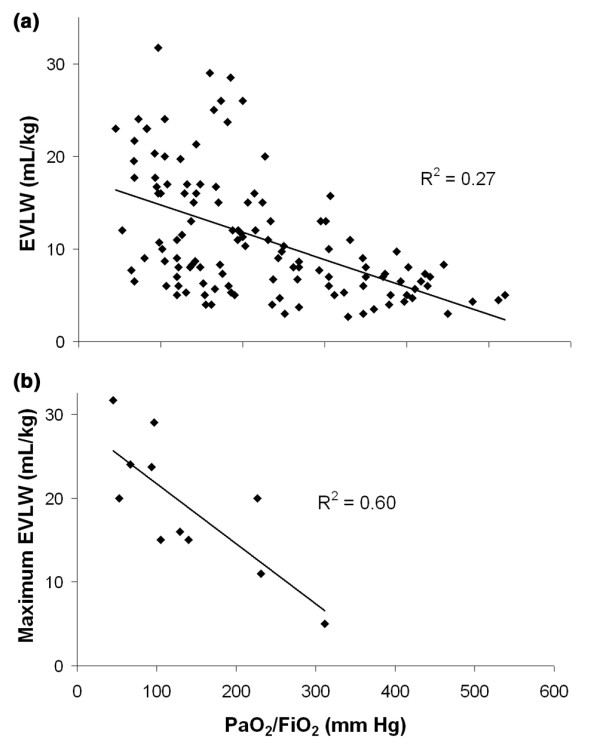
Scatter plot showing the relationship between (a) oxygenation (arterial oxygen tension [PaO2]/inspired fractional oxygen [FiO2] ratio) and extravascular lung water (EVLW) in all patients (R2 by linear regression = 0.27; P < 0.001), and (b) between minimum PaO2/FiO2 ratio and maximum EVLW in nonsurvivors (R2 = 0.60; P = 0.005).